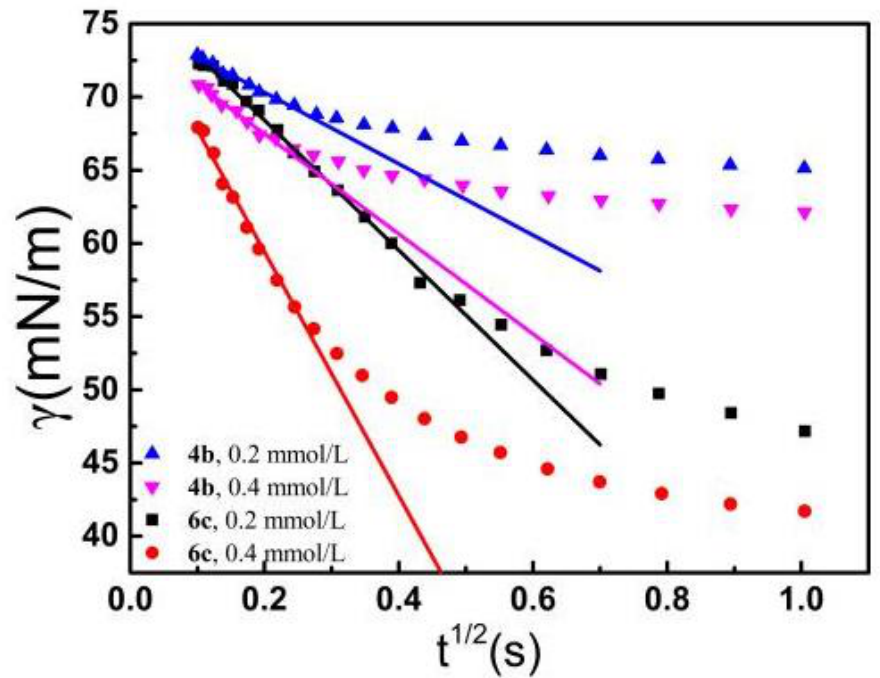
Figure 8. Linear behavior of γ ( t )— t 1/2 determined by the short time of 4b and 6c . Table 3. Diffusion coefficients of surfactants 4a , 6a , and 6b .